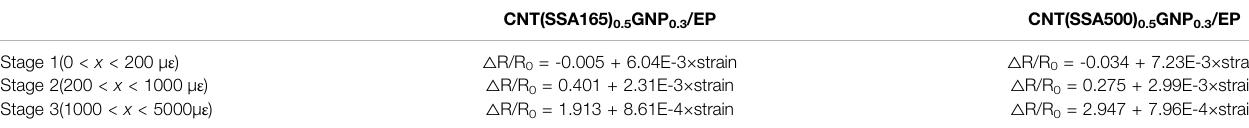
TABLE 3 | The fi tting parameters of three stages for composites with CNT(SSA165) 0.5 GNP 0.3 and CNT(SSA500) 0.5 GNP 0.3 .